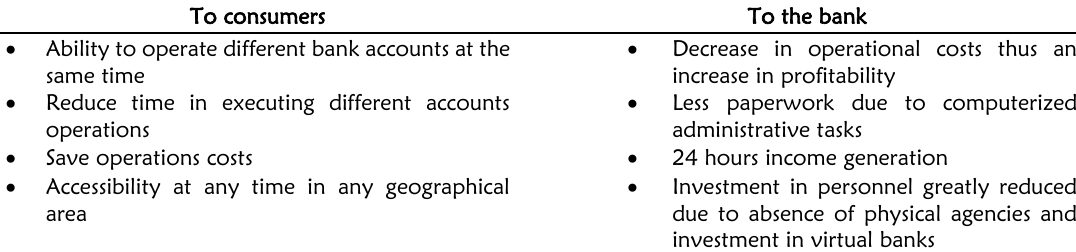
Table 2: Banks that have recently reported cyber-attacks. Source: Bouveret